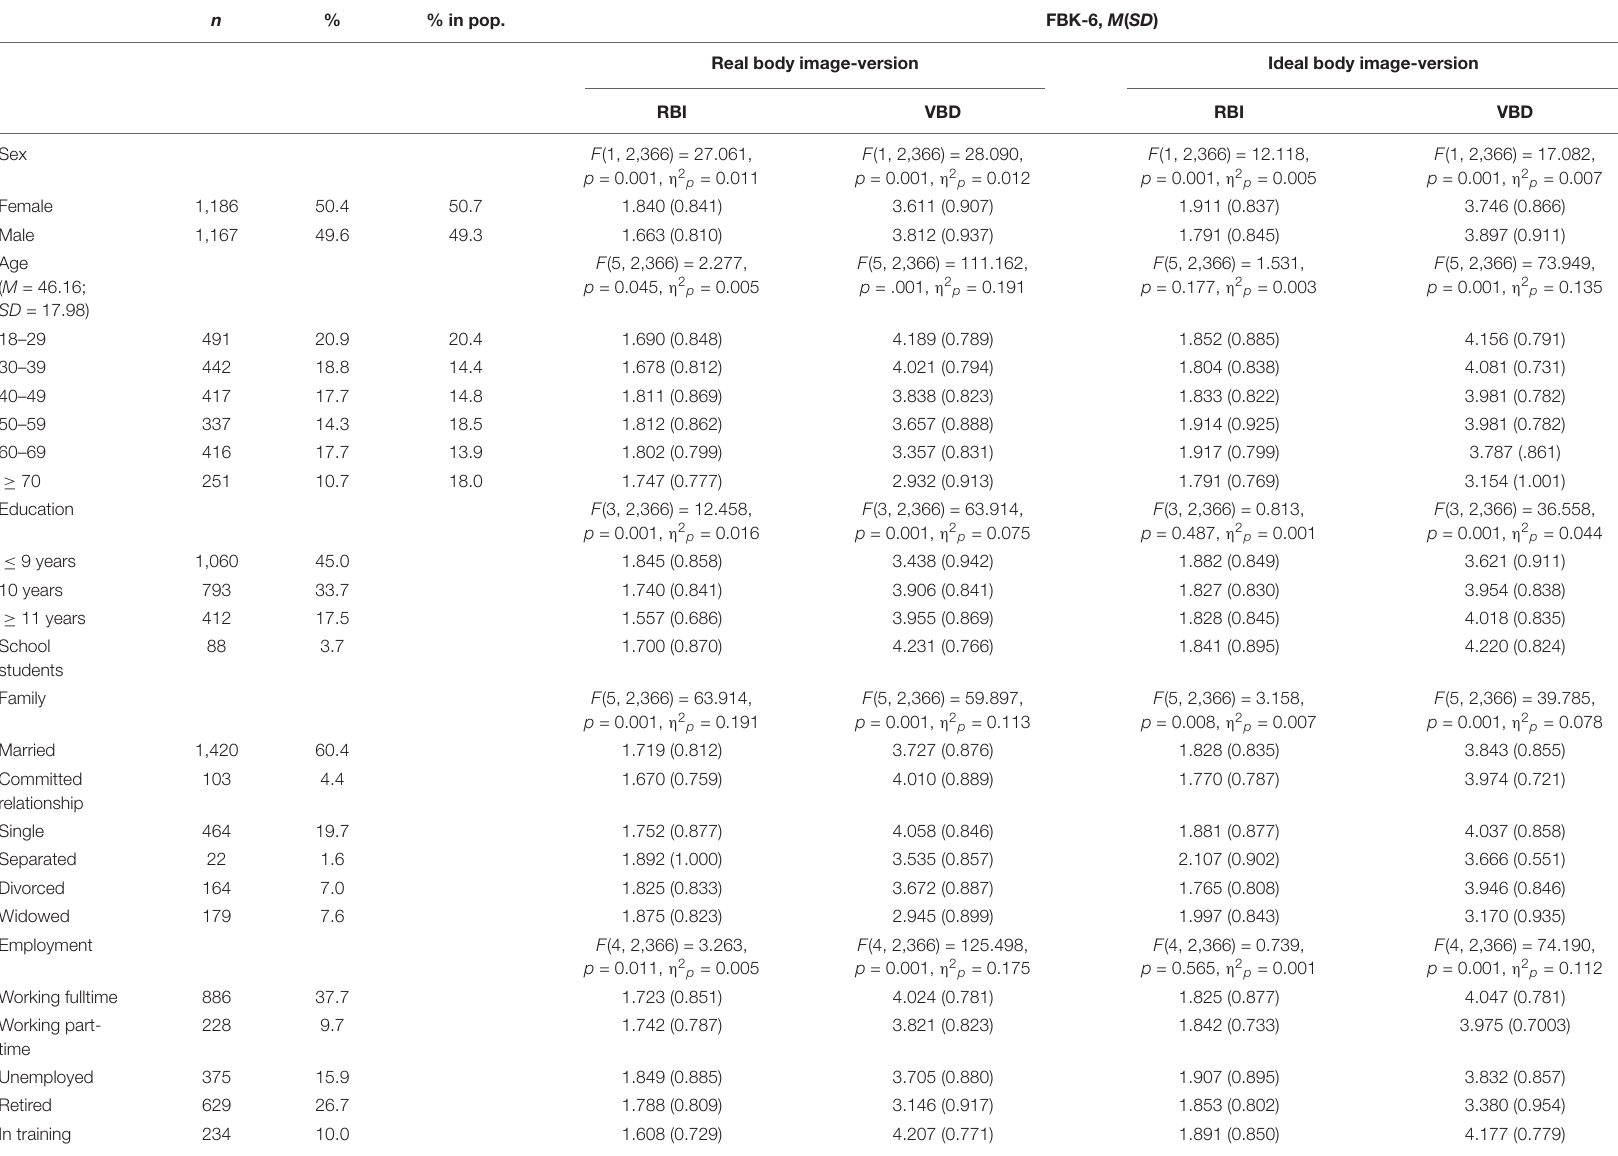
FBK-6 = Six-item version of the Body Image Questionnaire; % in pop = Distributions in the German general population, according to the Federal Statistical Office of Germany